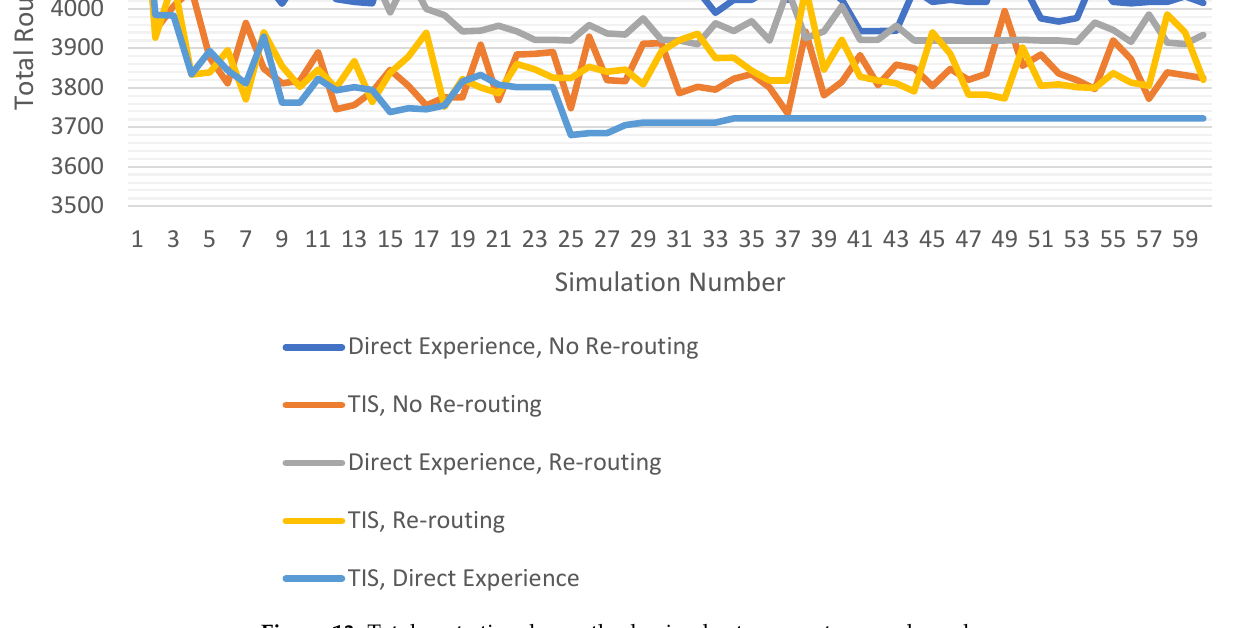
Figure 13. Total route time by method using best